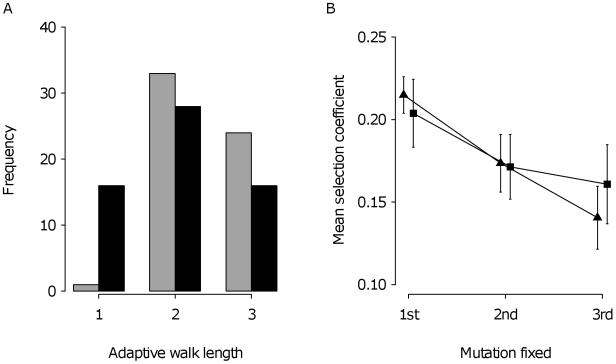
Properties of adaptive walks.(A) Distribution of walk lengths for the experiment. Bars represent observed walk lengths for large (grey) and small (black) bottleneck treatments. (B) Relationship between mean effect size and the number of steps in an adaptive walk for large (diamonds) and small (squares) bottleneck treatments. Error bars indicate ±standard error of the mean. Slopes are significantly negative; see text and Table 1.